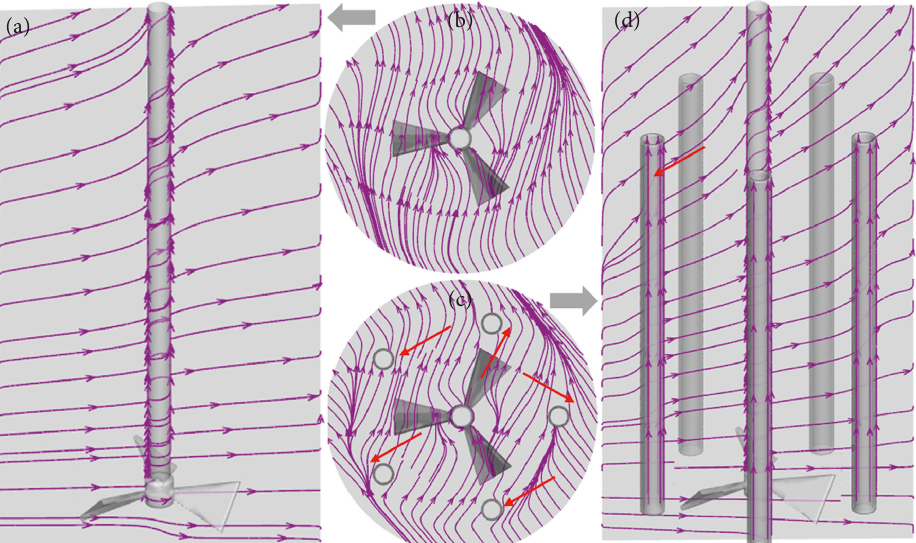
Figure 6: The distribution of fluid flow traces in the tank. (a, b) Flow trajectory on the vertical and horizontal planes under traditional stirred tank. (c, d) Flow trajectory on the vertical and horizontal planes under dynamic-static combined stirred